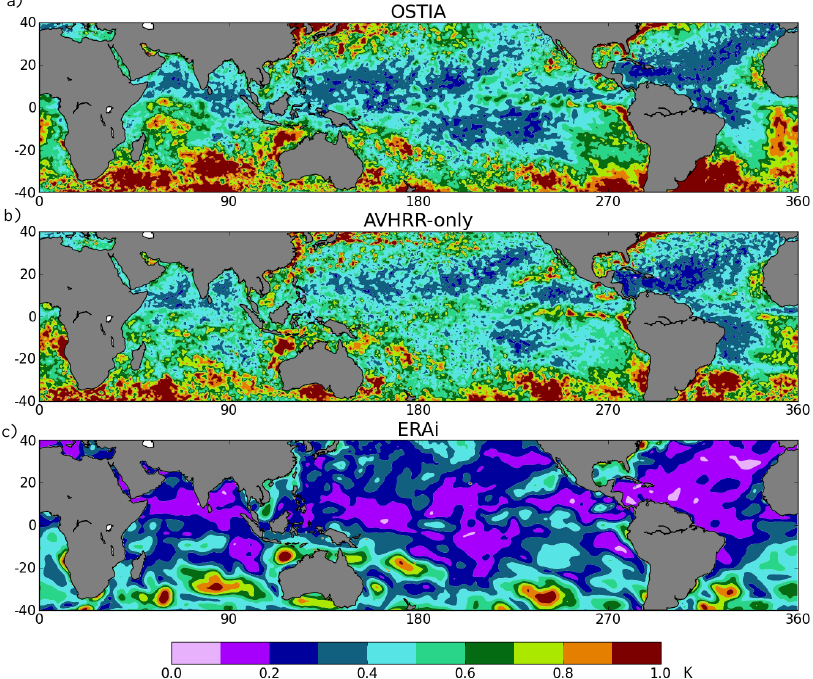
Fig. 2. (a) Standard deviation (in K) of OSTIA SST anomalies over the winter (December to March) 1992–1993 in the Tropics. (b) and (c) Same as (a) for AVHRR SST and ERAi SST, respectively. Anomalies are estimated with respect to the 1985–2006